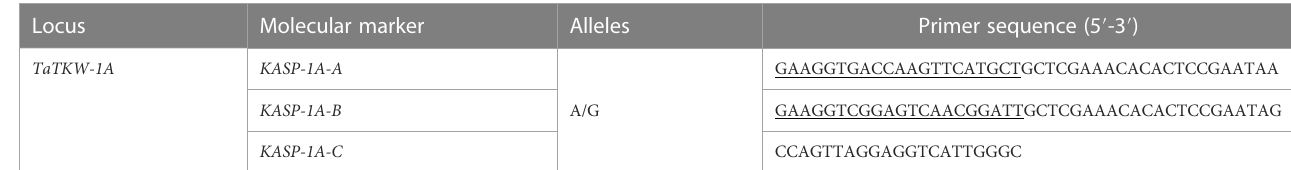
TABLE 3 The KASP molecular marker sequence of TaTKW-1A .